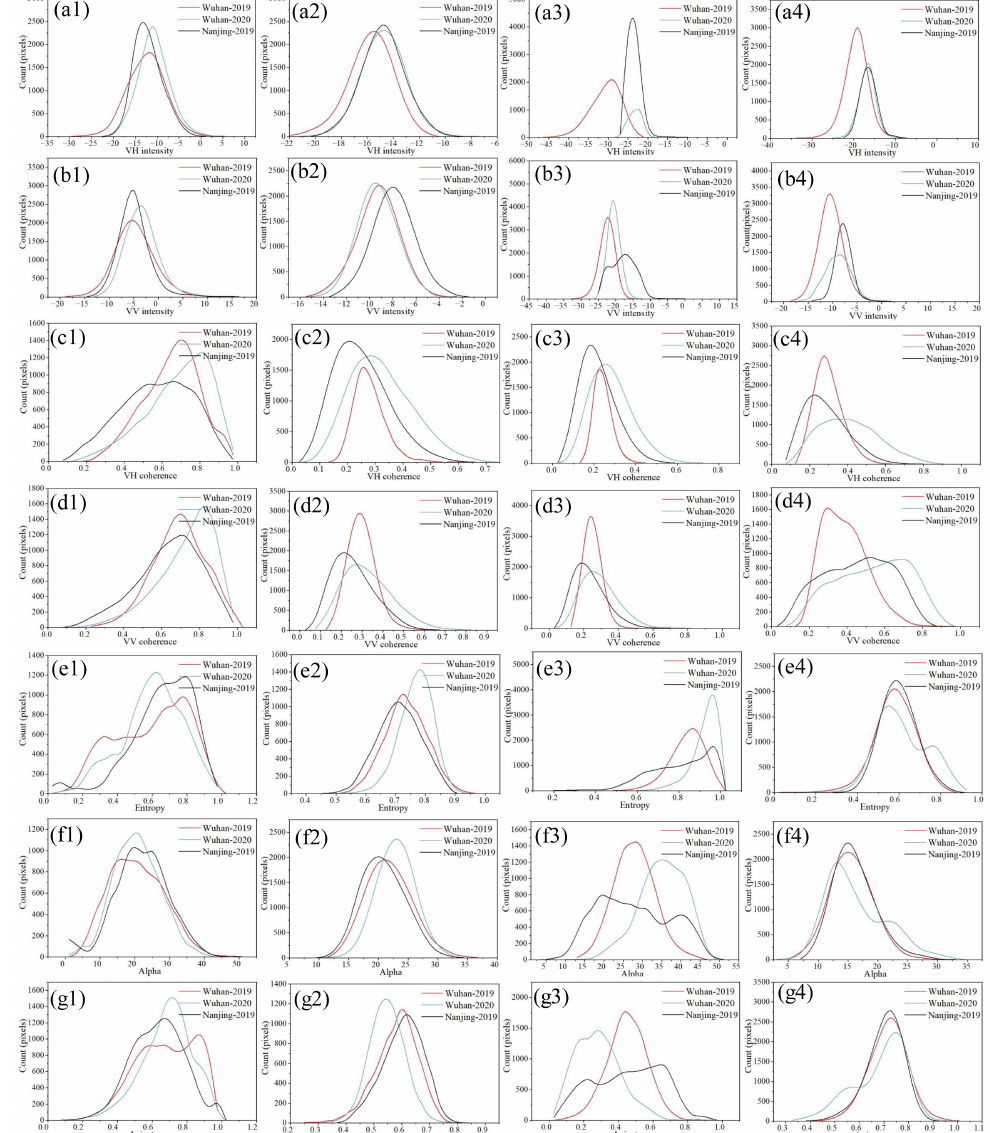
Figure 14. Spatial and temporal distribution differences in SAR features of impervious sur- faces, vegetation, water bodies, and bare soils. ( a1 – g1 ) Impervious surfaces, ( a2 – g2 ) vegetation, ( a3 – g3 ) water bodies, and ( a4 – g4 ) bare soils,